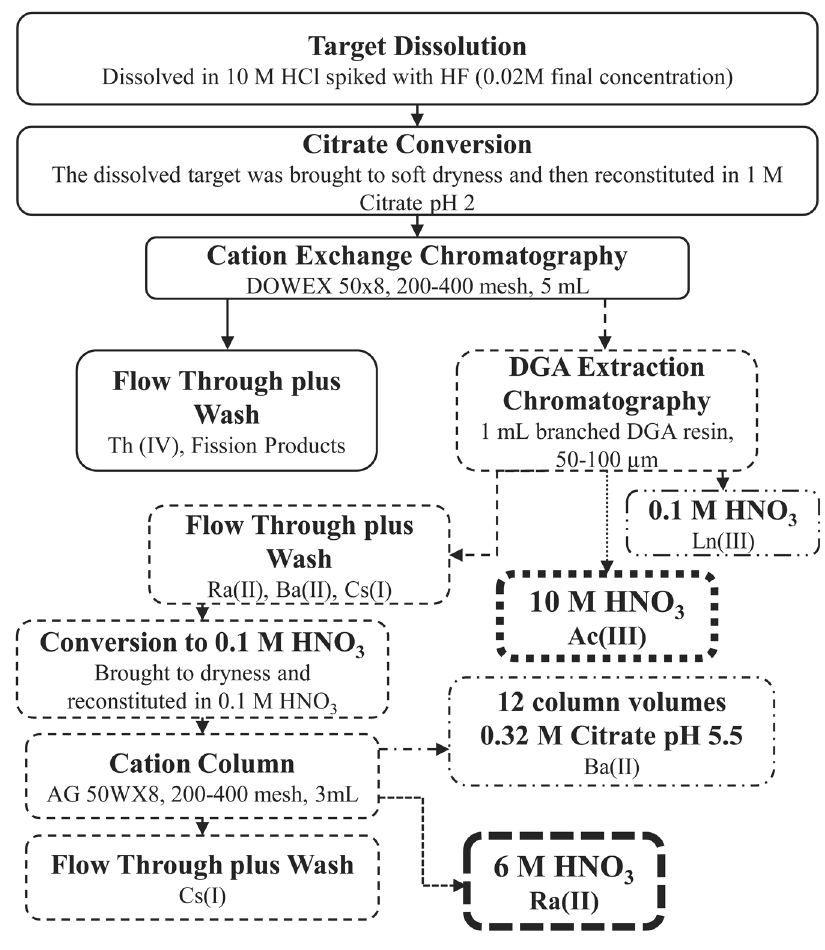
Figure 4. Final 225 Ac separation schematic with recovery of radium